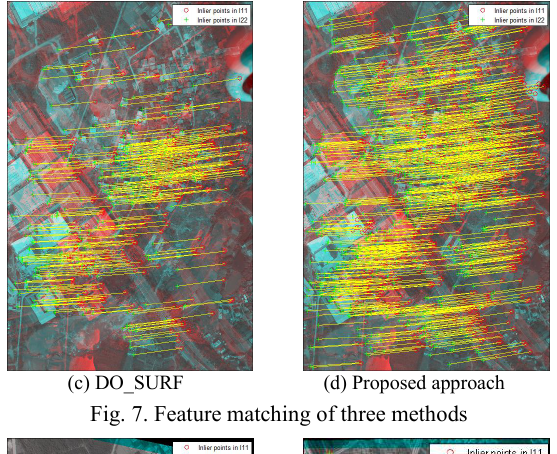
Fig. 7. Feature matching of three methods